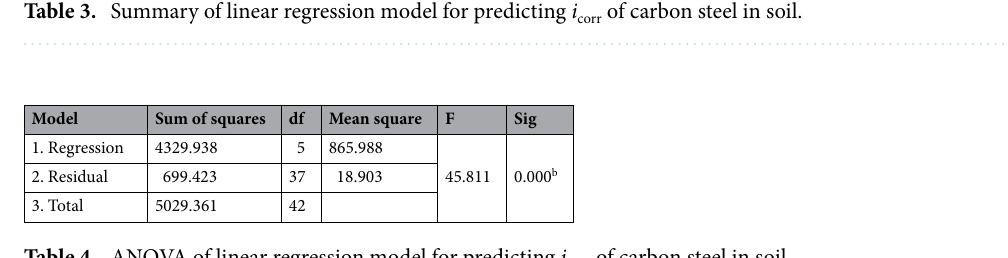
Table 4. ANOVA of linear regression model for predicting i corr of carbon steel in